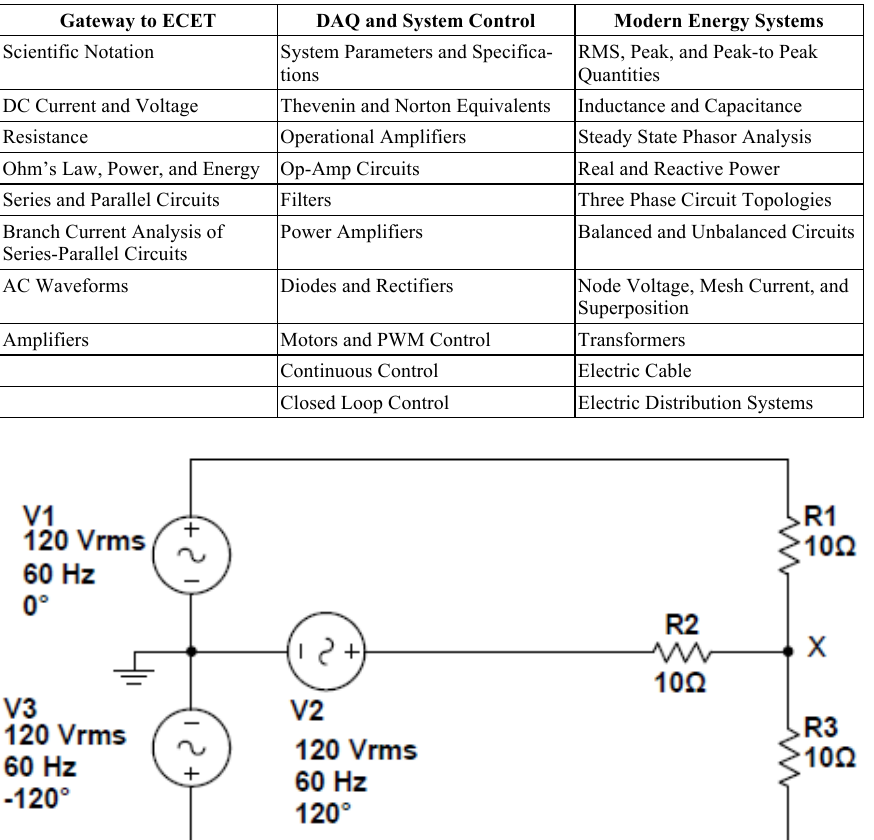
Table 3. Topic organization for introductory ECET Circuit Analysis curriculum